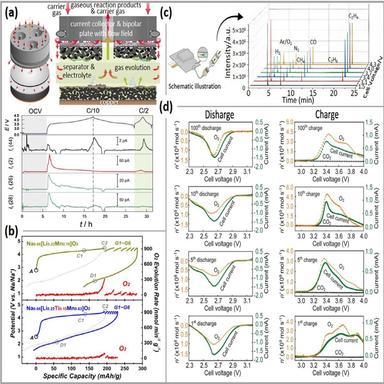
(a) Schemes of the NCM 532/graphite battery components (upper) and MS data of diverse m/z values during the operation (bottom) (Reproduced with permission from ref. Copyright 2015 American Chemical Society); (b) in-situ DEMS results of Na0.66Li0.22Mn0.76O2 and Na0.66Li0.22Ti0.15Mn0.63O2 cathode in Na-ion batteries (Reproduced with permission from ref. Copyright 2019 American Chemical Society); (c) schematic description of the in-situ lithium-ion pouch cell with gas port and the